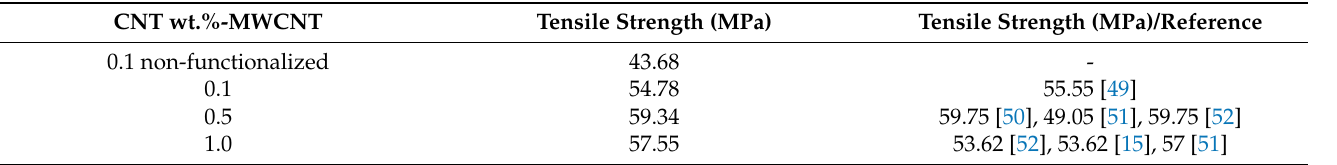
Figure 10. Flexural strength variation for non-functionalized (Sample-1: 0.1 wt.%) and functional- ized (Sample-2: 0.1 wt.%; Sample-3: 0.5 wt.%; and Sample-4: 1.0 wt.%) MWCNT nanocomposites. Table 5. Comparison of tensile strength of MWCNT-reinforced PMMA nanocomposites. Tensile Strength (MPa) Tensile Strength